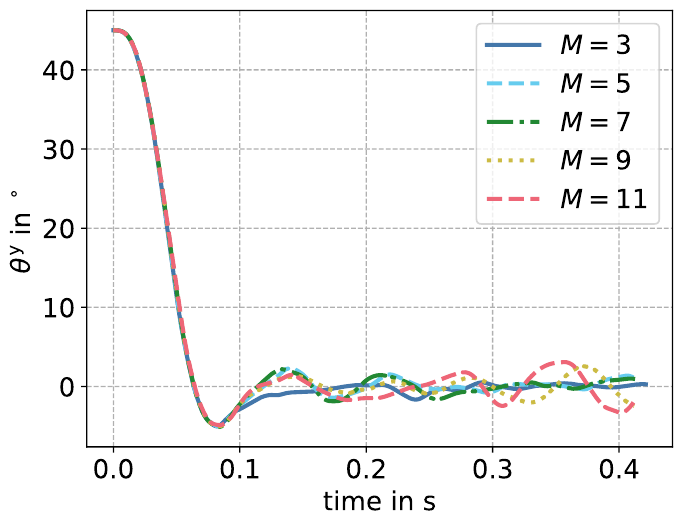
Figure 6. Plot of the angle for rotation around the y -axis over time during the settling. Results printed for different grid spacings, for the particle with the longest